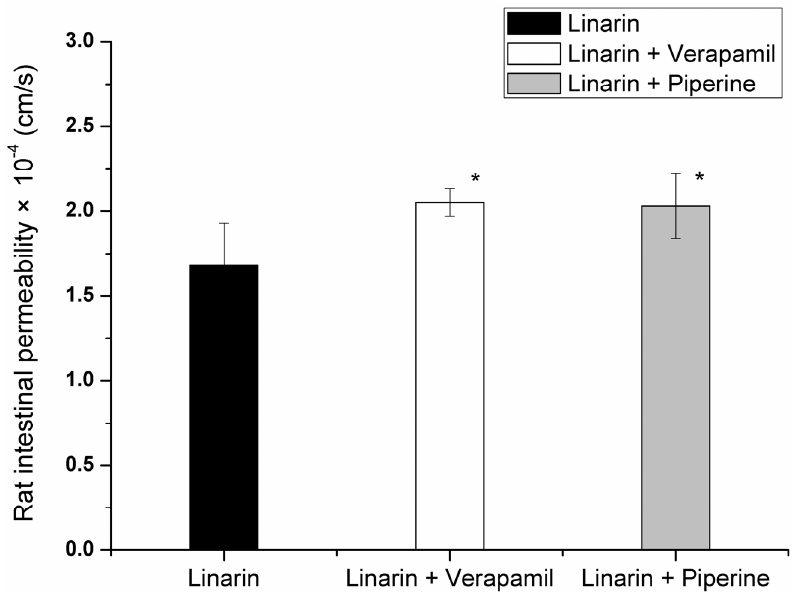
Figure 2. Rat intestinal permeability of linarin in the absence and presence of verapamil or piperine. * p < 0.05 as compared to linarin.